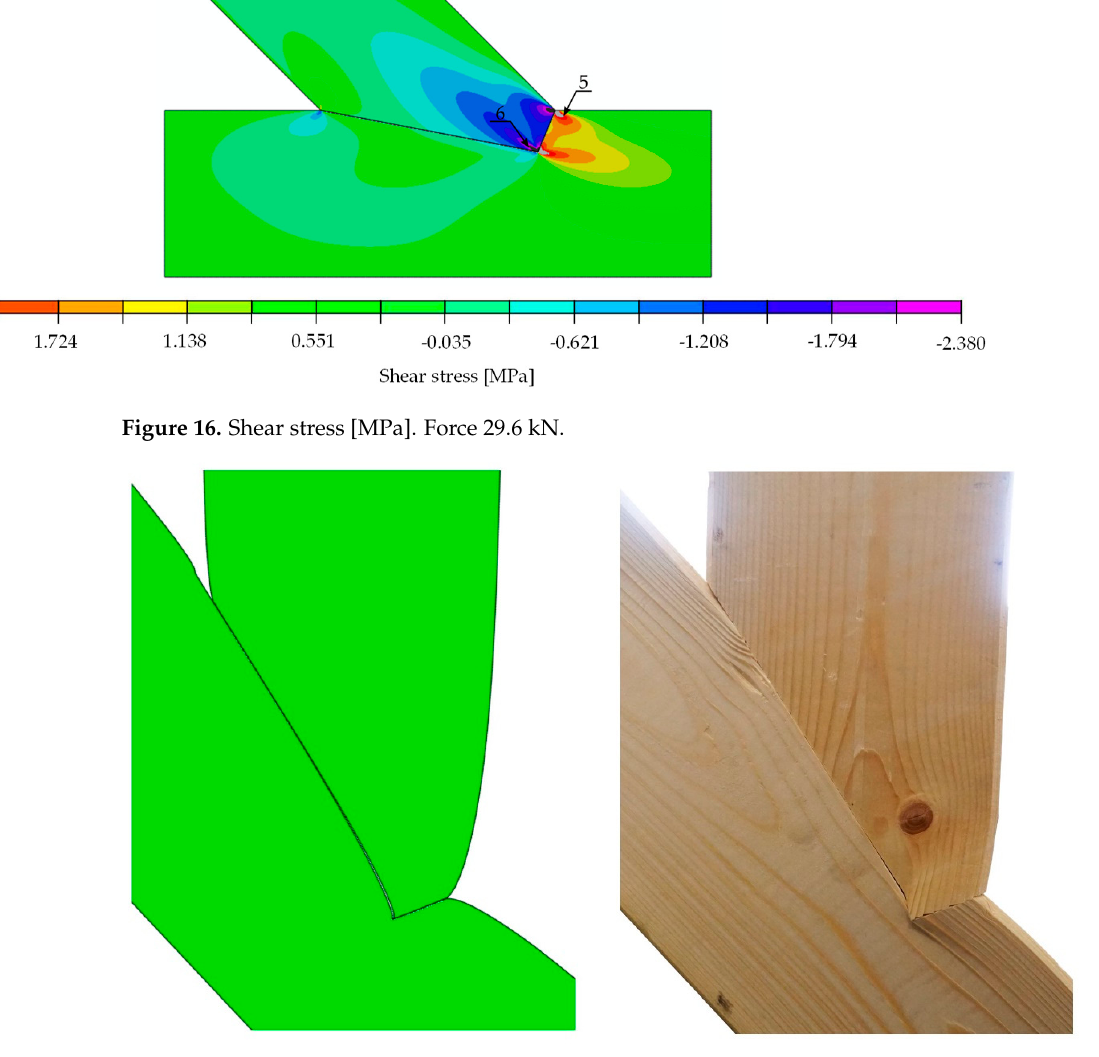
Figure 18. Geometrical data of the FEM model for the double-step joint. Axis 1 represents the ori- entation parallel to the grain. The results of the experimental investigation of Series B are presented in Figure 19 in form of a force-displacement diagram, serving as a reference for the validation of the pre- dicted stiffness. The test series consisted of three specimens tested under the same condi- tions as Series A. Furthermore, the specimens were produced out of the same material.